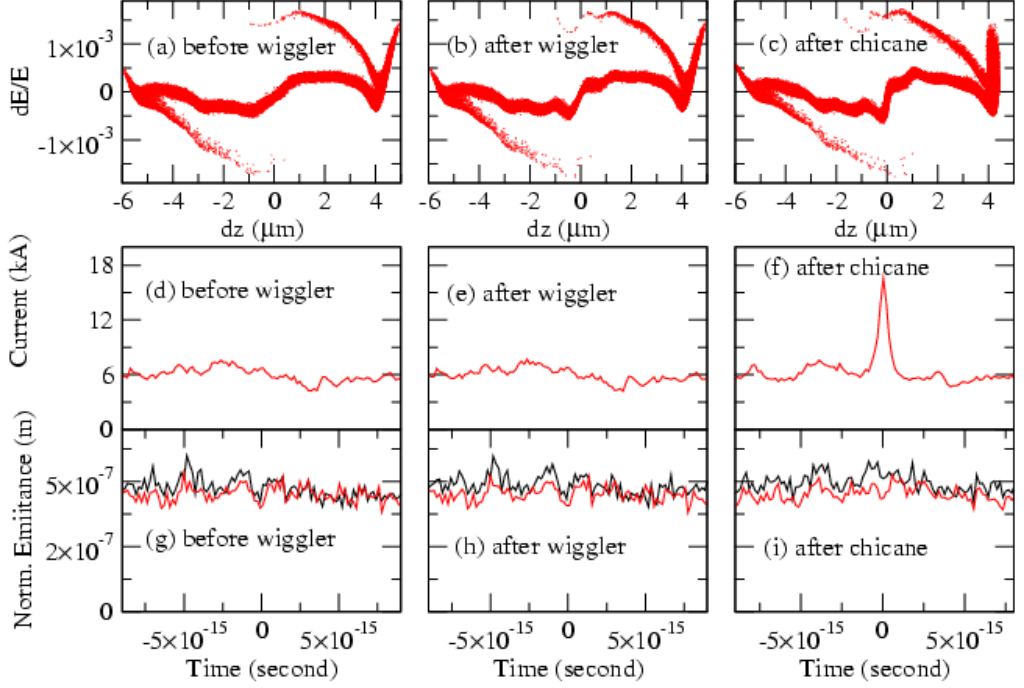
Figure 10. (Color online). The change of the characteristics of the 6 kA, 12 μm-long electron bunch. ( a )–( c ): the longitudinal energy distribution. ( d )–( f ): current profile. ( g )–( i ): horizontal (black line) and transverse normalized-emittance (red